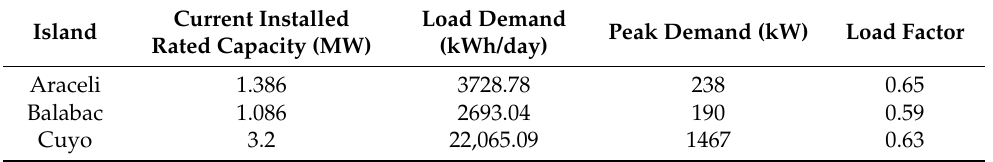
Figure 3. Study areas in Palawan, Philippines. Table 1. Electric load profile of the study areas.